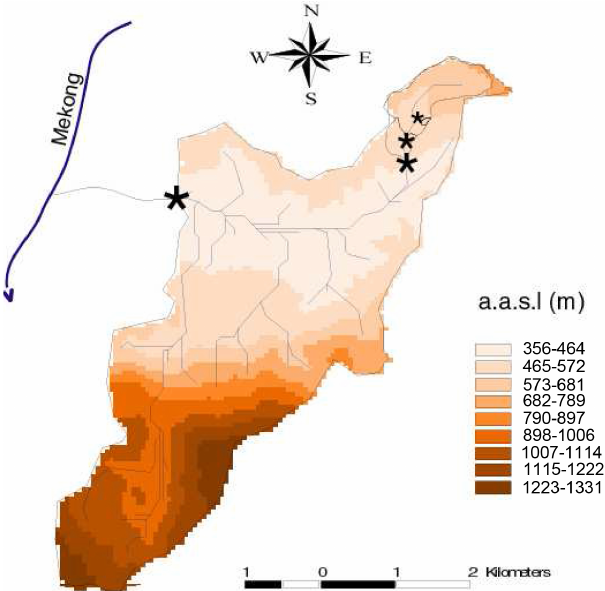
Figure 1. Topography of the study area in northern Laos and lo- cation of the sampling sites at the outlet of the 0.6 × 10 4 m 2 , 30 × 10 4 m 2 , 60 × 10 4 m 2 and 1 × 10 7 m 2